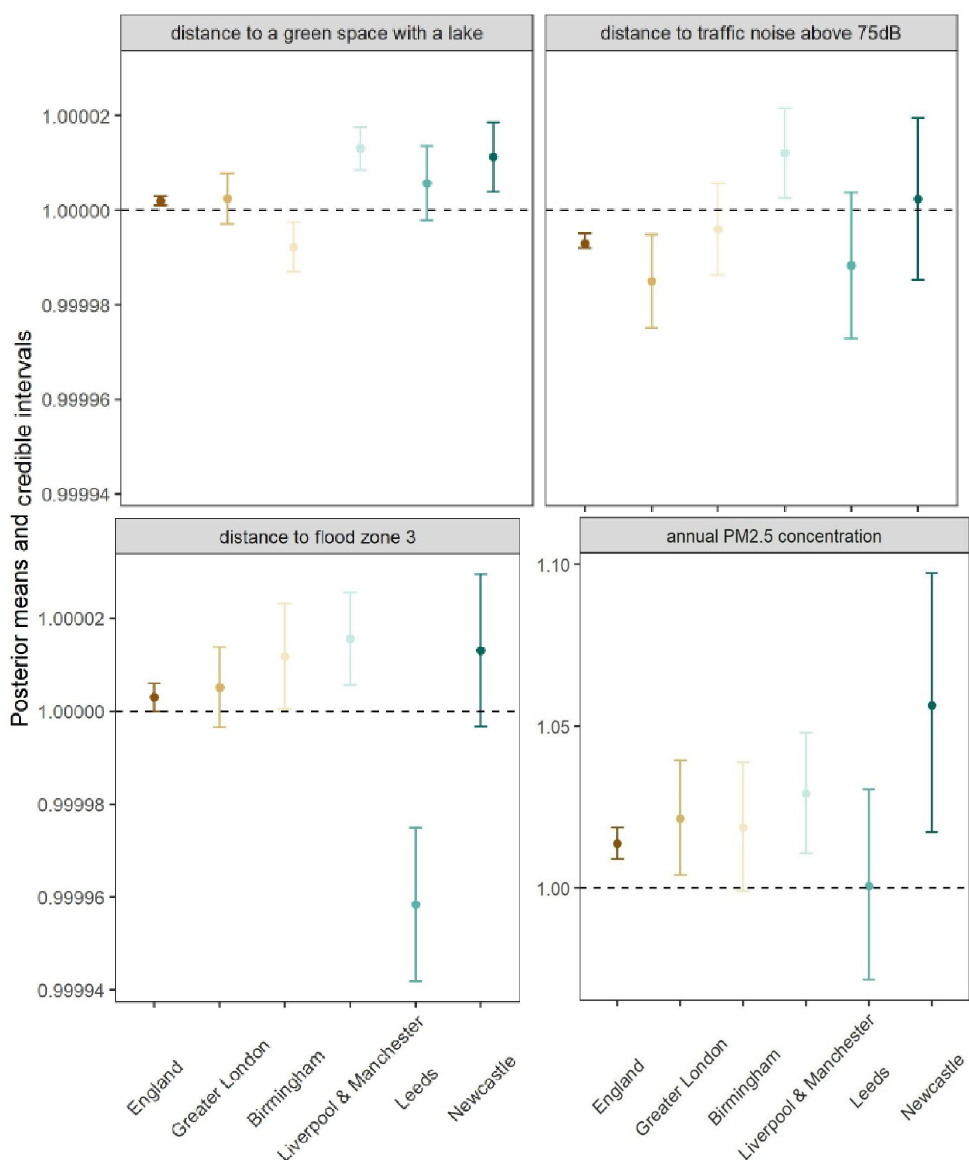
Fig 1. Posterior estimates (posterior mean and 95% credible interval represented by the dot and the vertical interval, respectively) of the PR of the environmental variables on mean SMI prevalence estimated from the full model. For all 4 covariates, the estimated covariate effect greater than 1 suggests that an LSOA with a larger covariate value (e.g., a higher annual PM 2.5 concentration) was associated with a higher SMI prevalence. An estimate with its 95% CI excluding 1 indicates a high certainty that a covariate-outcome association exists. Note: The y axis plot for PM 2.5 concentration is presented on a different scale to the other plots in the figure. LSOA, Lower Layer Super Output Area; PR, prevalence ratio; SMI, serious mental